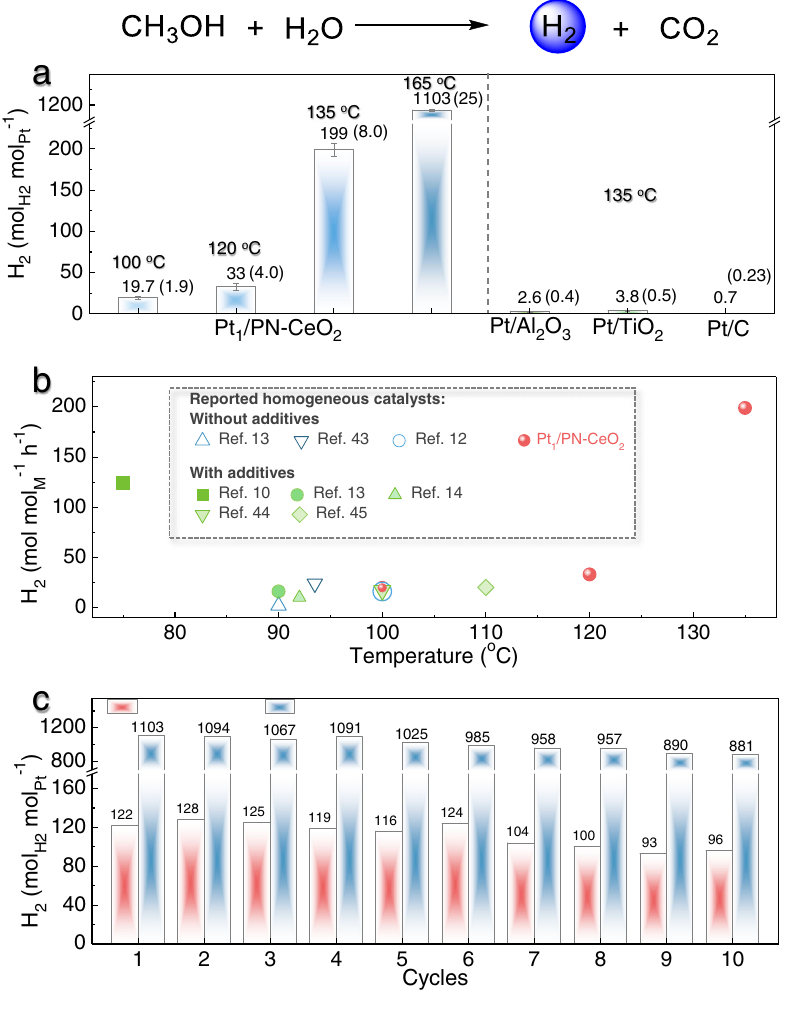
Fig. 3 | Catalytic performance. a H 2 generation from methanol and H 2 O catalyzed by various Pt catalysts. The error is derived from three parallel experiments. Reaction conditions: catalysts (50mg), CH 3 OH (40mL), H 2 O (18mL), n(CH 3 OH):n(H 2 O)=1:1, and N 2 (0.4MPa). b Summary of the H 2 generation cata- lyzed by Pt 1 /PN-CeO 2 in the absence of additives compared with various reported